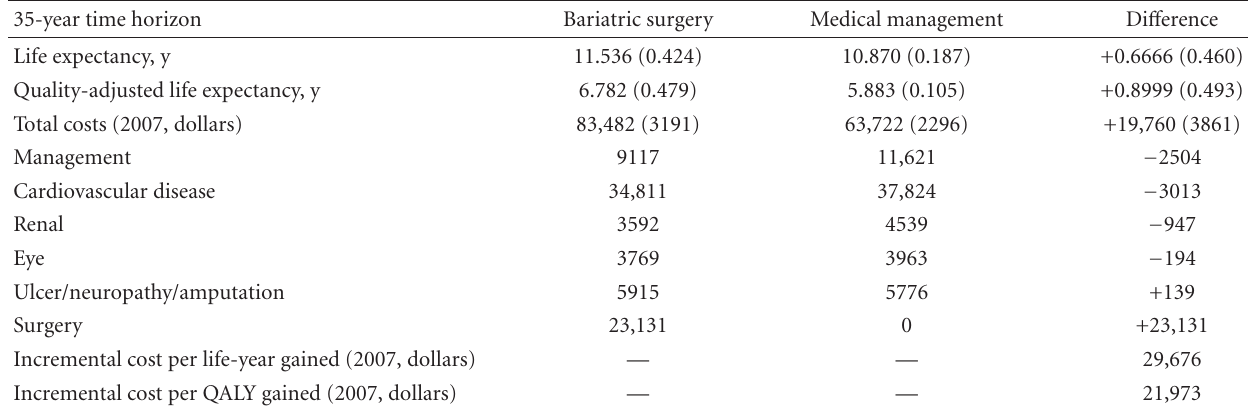
Table 2: Summary results for the base-case analysis